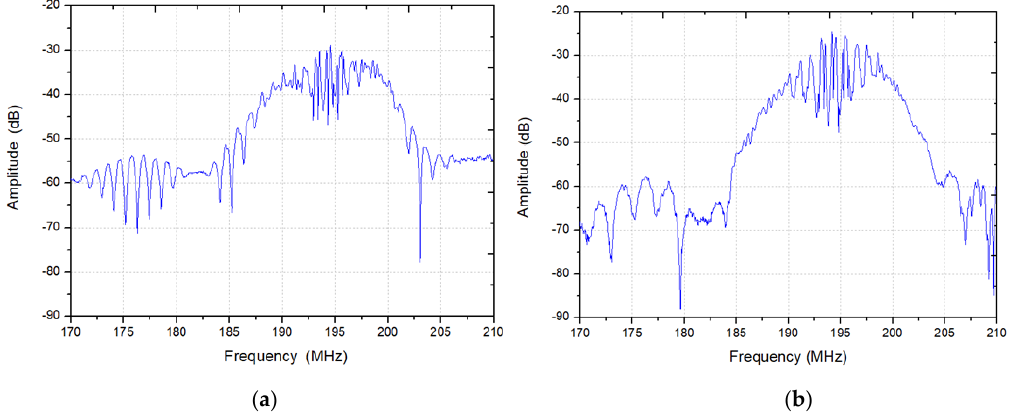
Figure 6. The measured frequency signals from T 1 ( a ) and T 2 ( b ). Sensors 2020 , 20 , x FOR PEER REVIEW